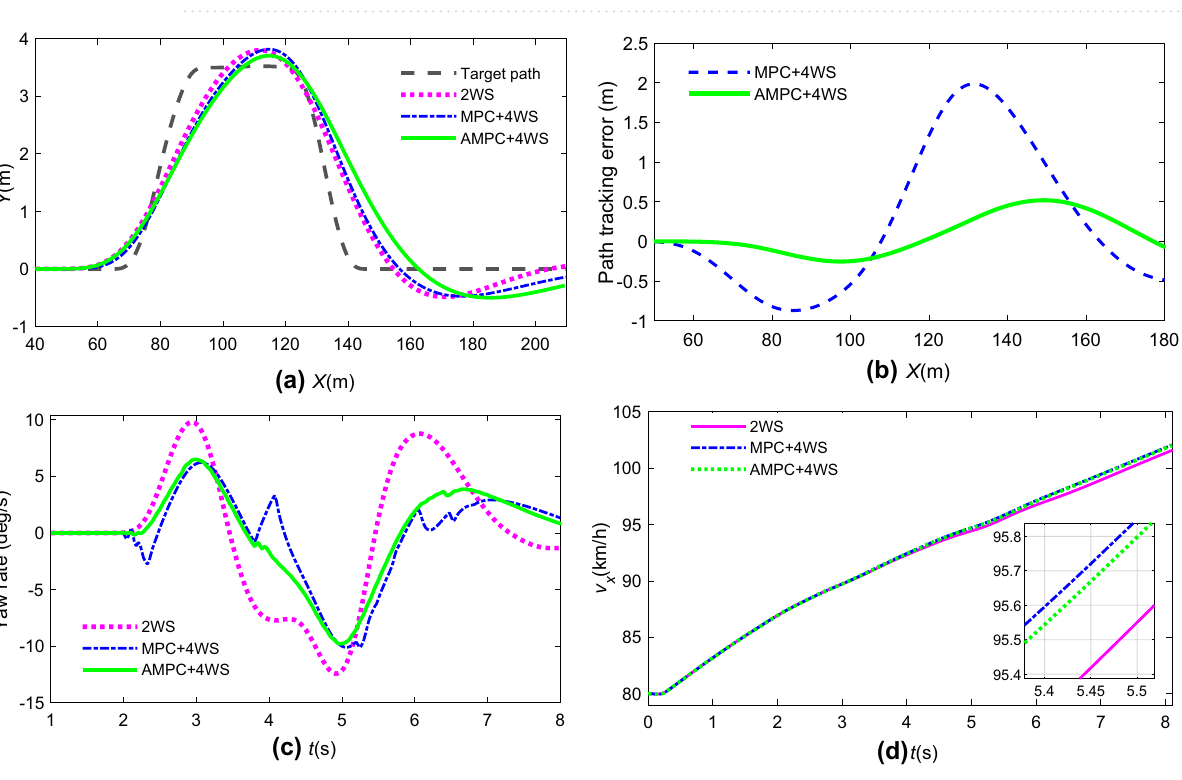
Figure 14. State response comparison at different longitudinal speeds: ( a ) path tracking; ( b ) yaw rate; ( c ) rear steering angle.